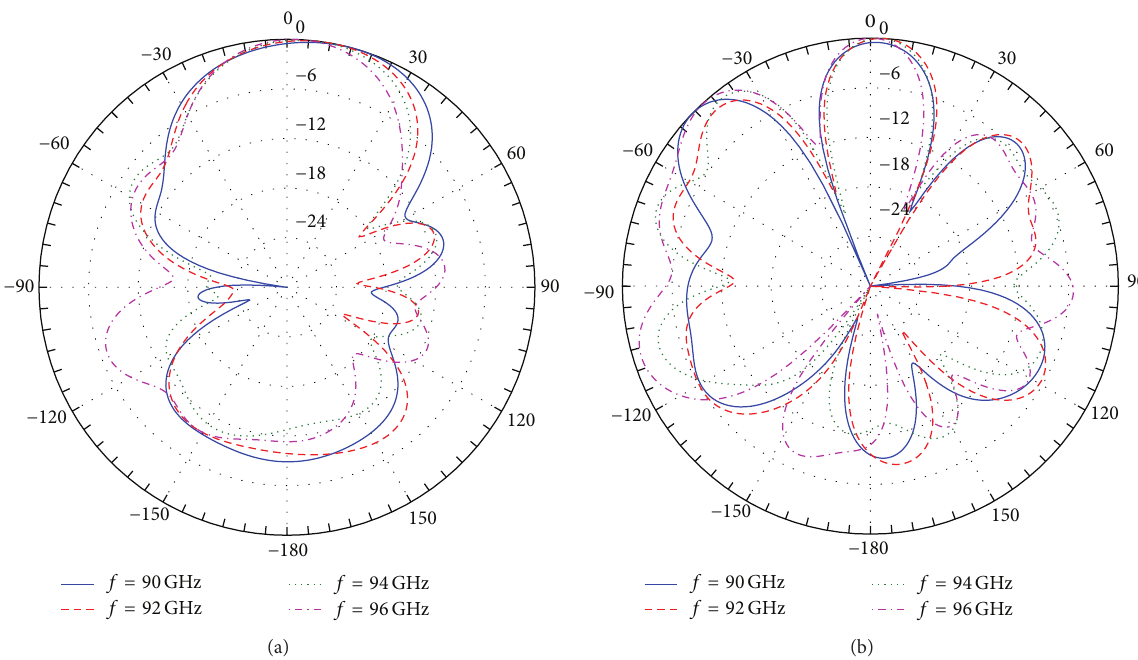
Figure4: Simulated radiation patternsin(a) 𝑌𝑍 planeand (b) 𝑋𝑌 planeat differentfrequencies 𝑓 = 90 , 92, 94, and 96 GHz forthe Quasi-Yagi loop array antenna prototype I.